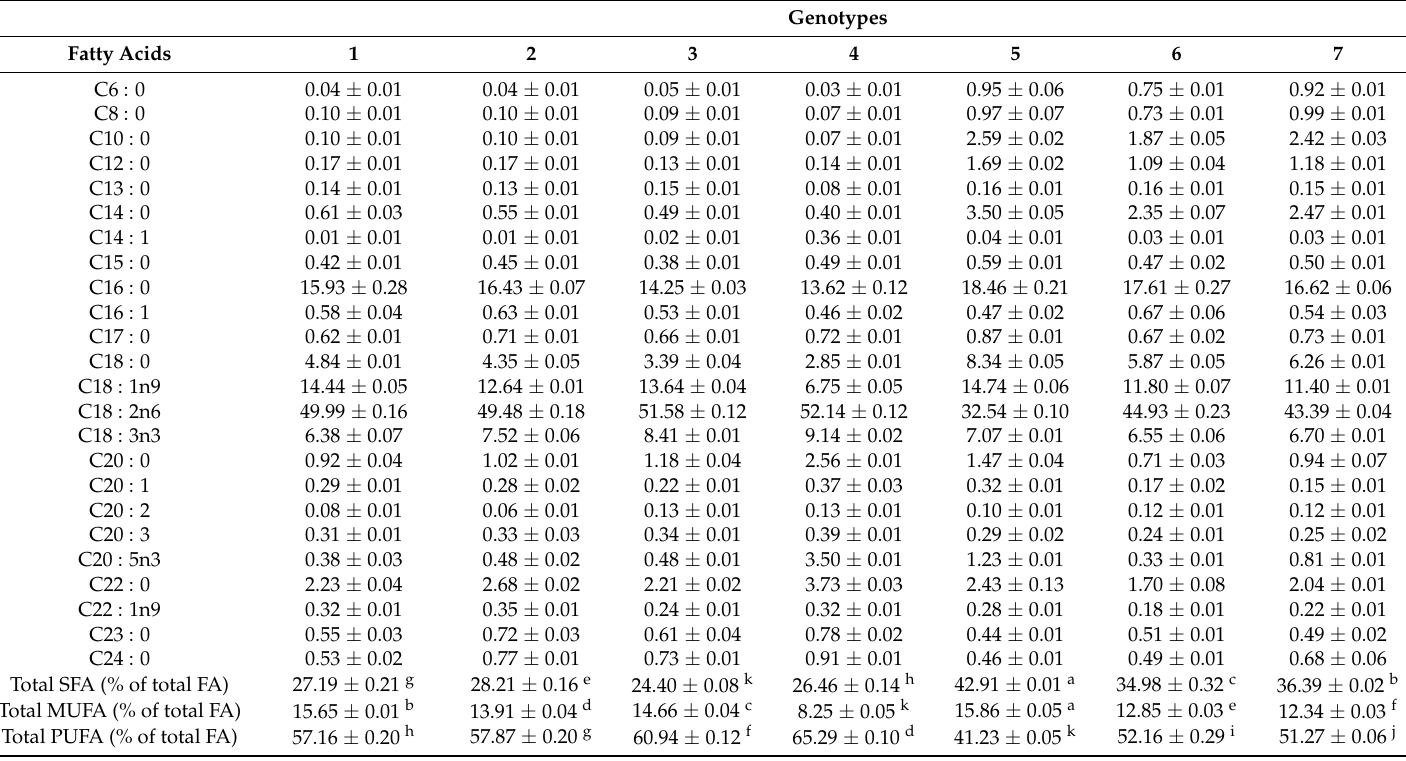
Table 5. Composition of fatty acids (relative %) of the studied garlic genotypes (mean ± SD; n =